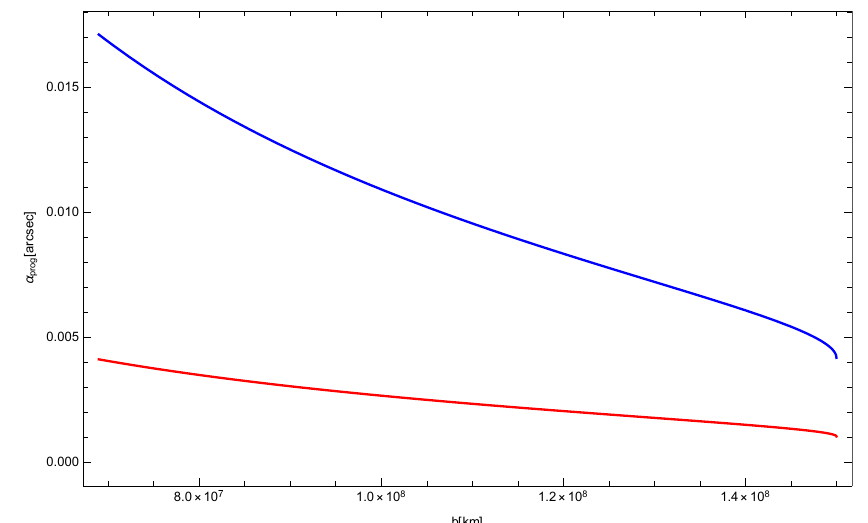
Figure 15. α for prograde motion of light: The horizontal axis is the impact parameter of photon orbit. The vertical axis means the deflection angle of light. The blue curve means the deflection angle with finite-distance corrections by the Kerr black hole. The red curve corresponds to that by the rotating Teo wormhole. For the purpose of this comparison, the mass of a Kerr black hole M and the throat radius of a rotating Teo wormhole b 0 are chosen as M = b 0 = M (cid:12) . The spin angular momentum of a Kerr black hole and that of a rotating Teo wormhole are chosen as the same as that the Sun for